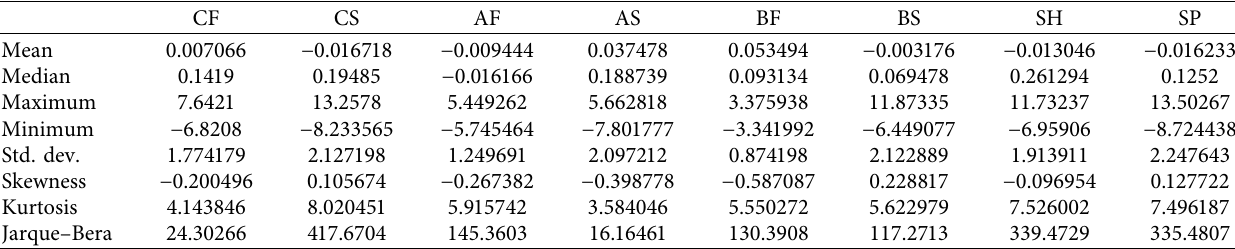
Table 1: Descriptive statistics.